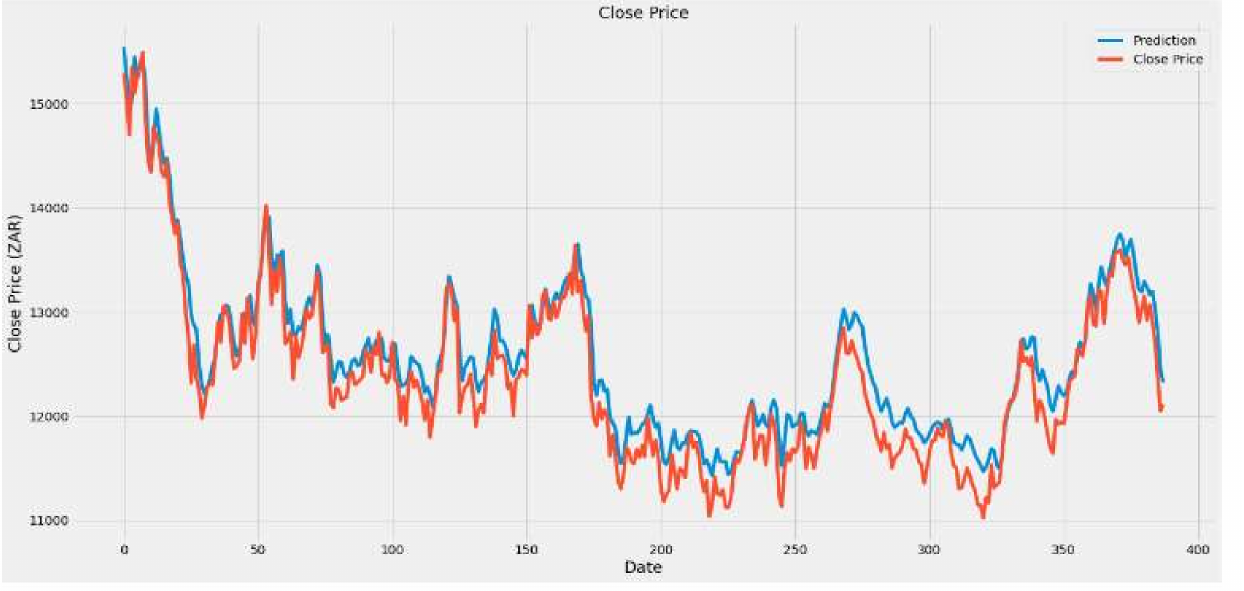
Figure 8. CNNxLSTM LSTM Experiment 2.2.